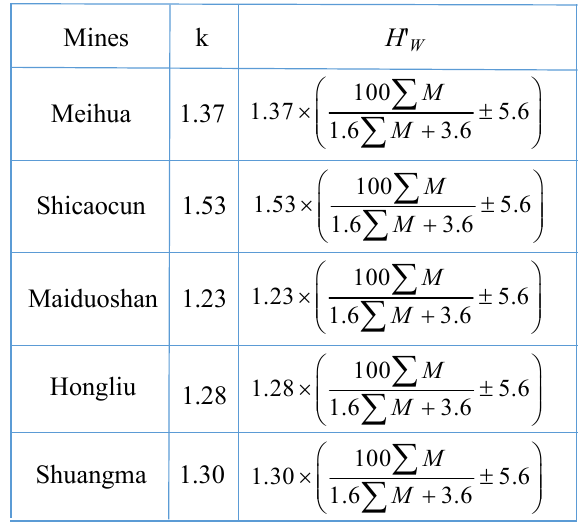
Figure 8. Calculation equation of development height of water-conducting fracture zone after correction.